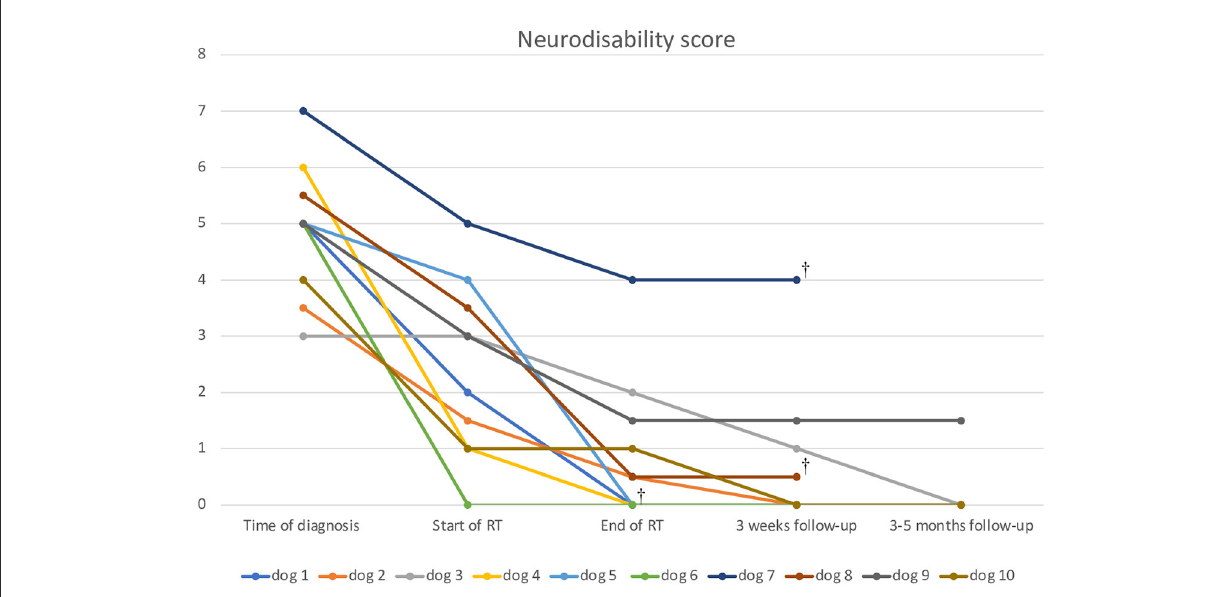
FIGURE1 The line diagram shows the progression of the neurodisability score of the dogs examined. The x-axis shows the time course, and the y-axis shows the disability score at the time of the examination.